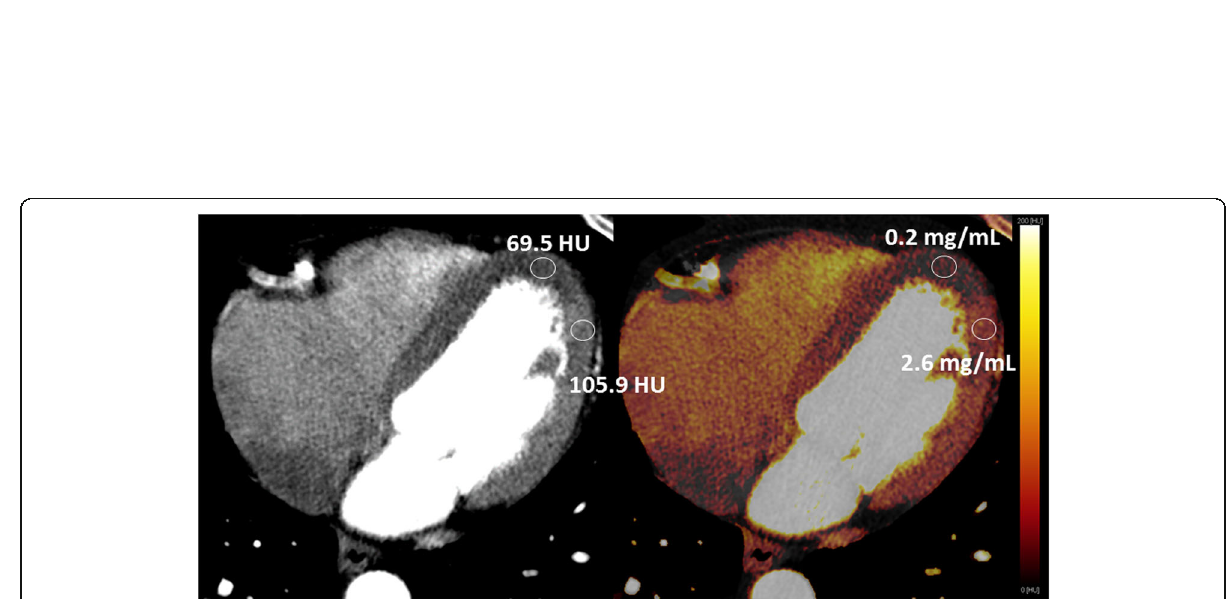
Fig. 4 The tissue attenuation curve (top figure) is lower for ischemic areas than for normal areas of the myocardium, causing ischemic myocardium to be visible as hypo-attenuated areas (red arrows, bottom figures). The static CT-MPI images represent multiple kV levels, showing the possibilities of dual-energy CT to enhance the hypo-attenuation of the ischemic area by using varying kV levels exploiting the dual-energy abilities. The blue boxed image represents the traditional single-energy static CT-MPI acquisition. The most right image shows a dynamic CT-MPI color-coded map (mL/100 mL/min) of the short axis based on quantitative myocardial blood flow data